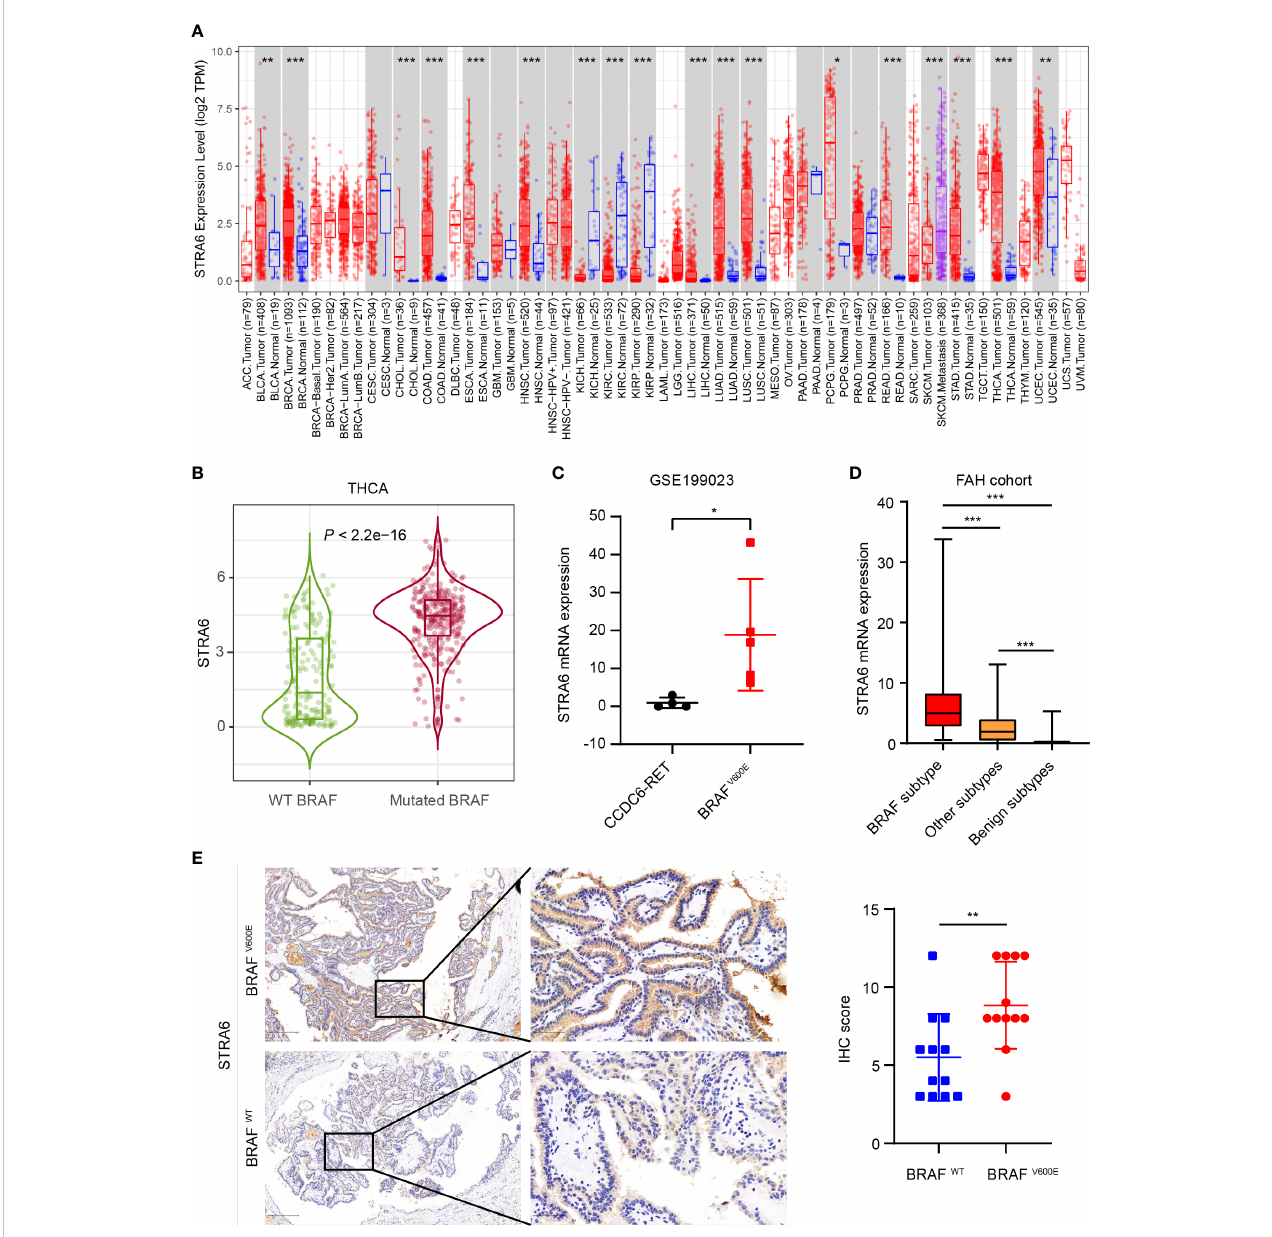
FIGURE 1 STRA6 is upregulated in BRAF-mutated PTC. (A) mRNA expression of STRA6 in various cancers according to the TCGA cohort. (B) STRA6 mRNA expression based on BRAF genotype in THCA cohort. (C) STRA6 mRNA expression of zebra fi sh thyroid tumors with oncogenic transfection gene in GSE199023. (D) mRNA abundance in FAH cohort with respect to different molecular subtypes. (E) Immunohistochemistry (IHC) staining of STRA6 protein level based on the BRAF mutation status in PTC samples. (*p < 0.05, **p < 0.01, ***p < 0.001. The data are shown as the mean ±